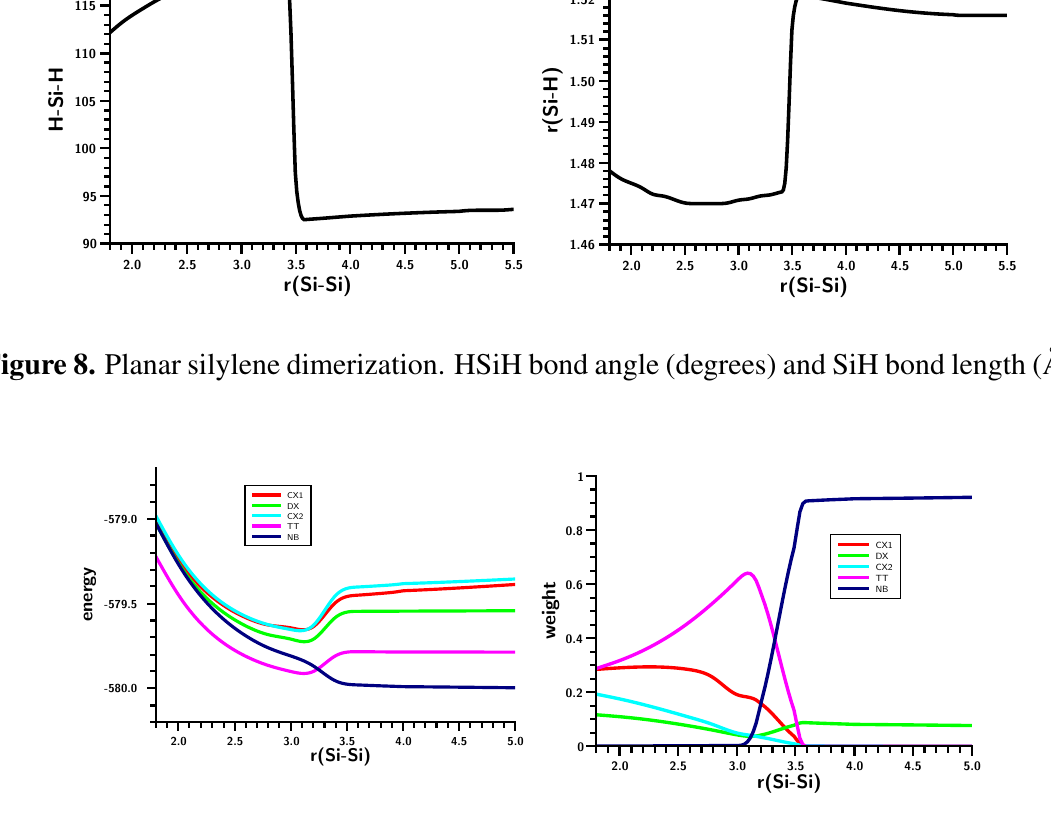
Figure 9. Planar silylene dimerization. Energies (left) and weight (right) of the six most important FO-CSFs. Energies in Hartrees; bond lengths in